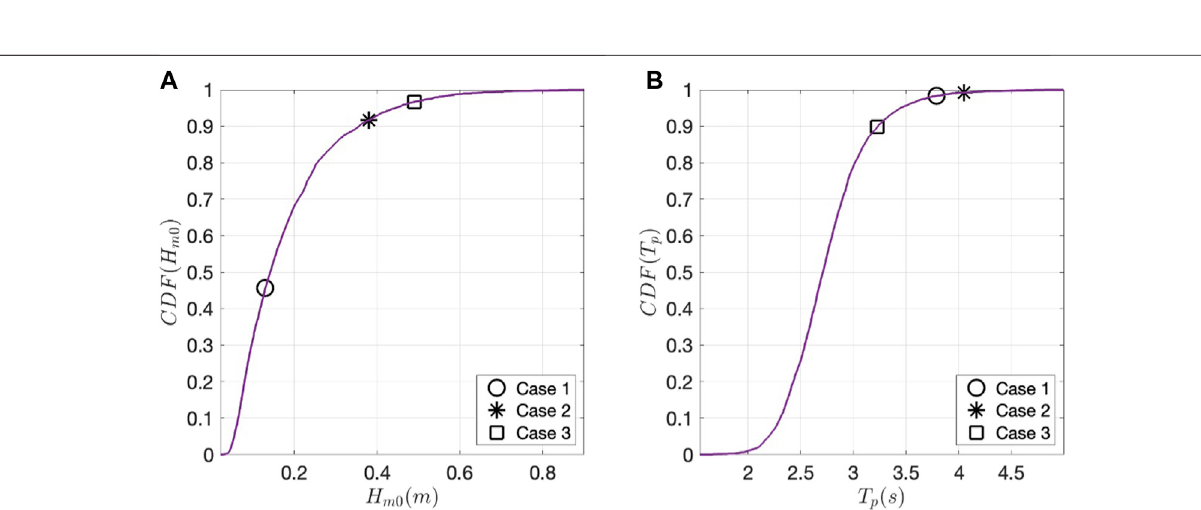
Frontiers in Built Environment |